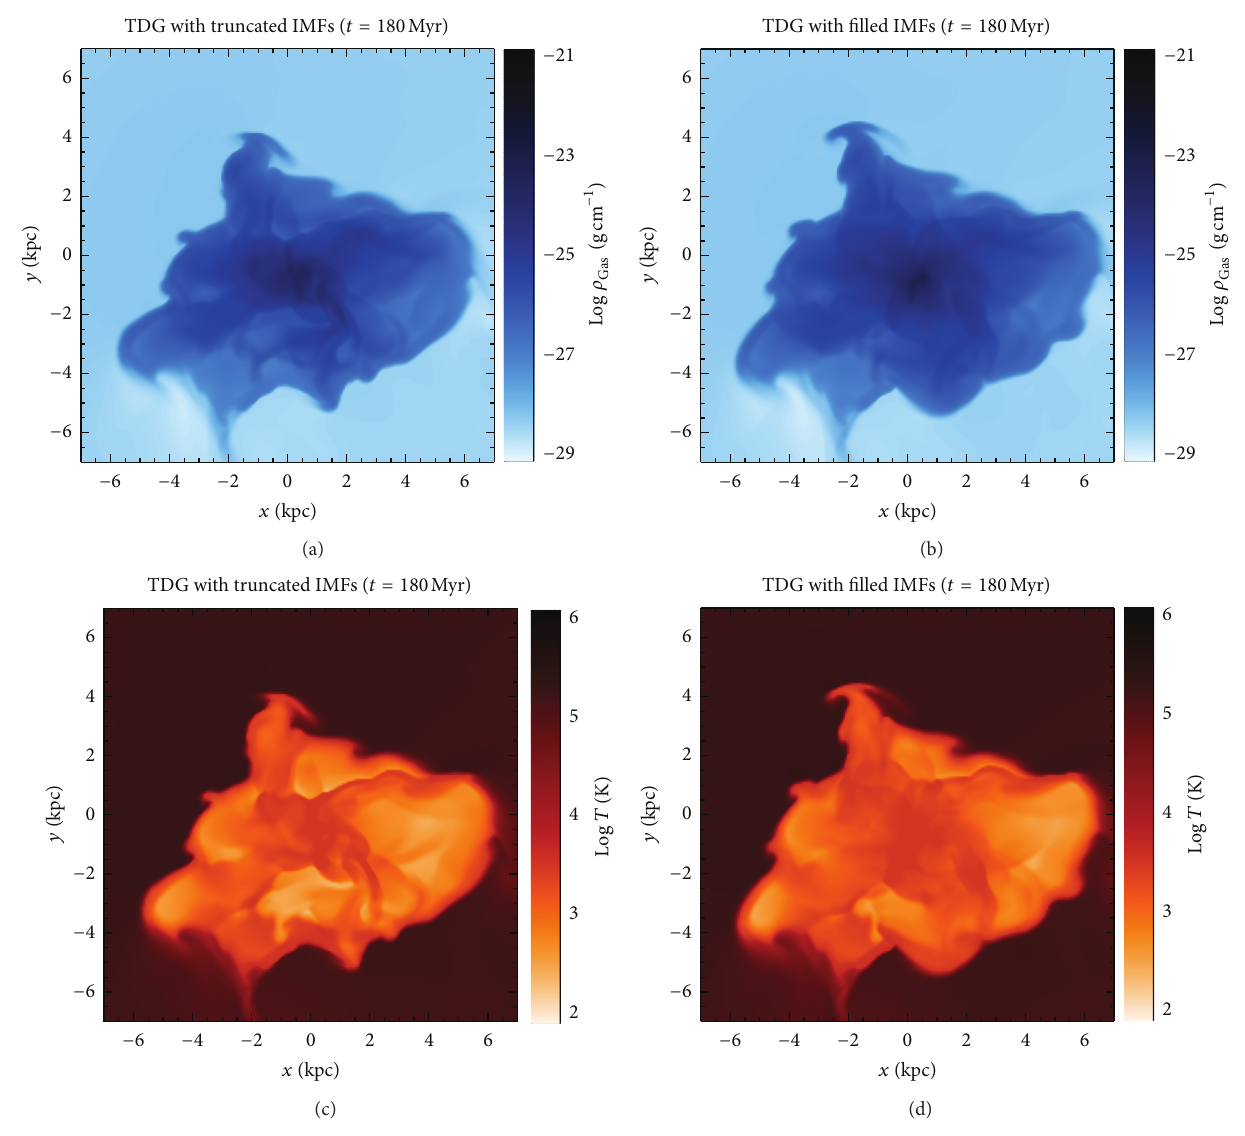
Figure 3: The density (a and b) and temperature (c and d) distributions after 180 Myr of evolution of two model galaxies. Strips on the right of each panel show the density and temperature scales. In one case (a and c), the upper mass in each formed star cluster depends on the total cluster mass (truncated IMF). In the other case (b and d), the upper IMF mass is always the same, irrespective of the mass of the star cluster. It is to notice that the temperature of the gas outside the galaxy has been set to 10 6 K. The temperature in the central region is hotter in the filled IMF model because of the larger amount of energy provided by